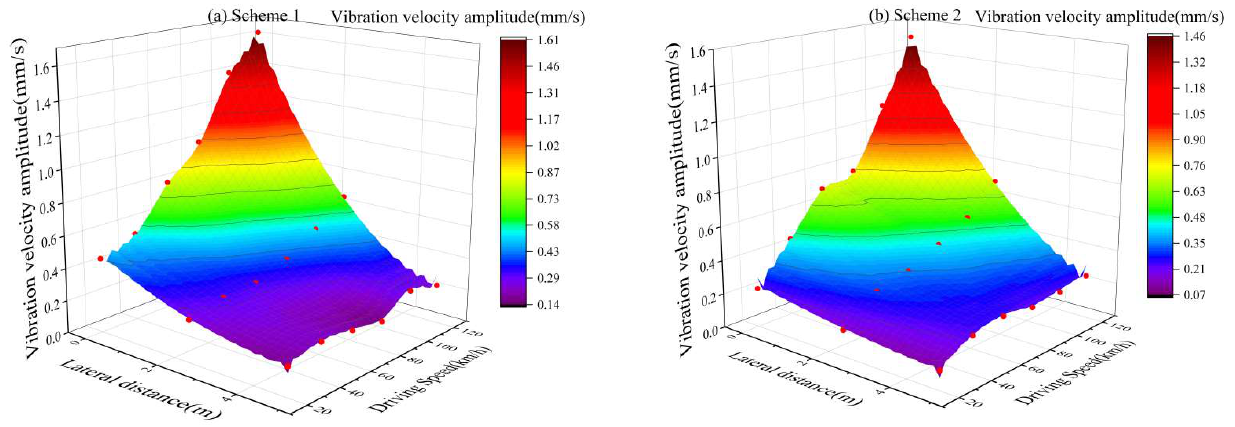
Figure 7. Actual vibration amplitude transverse decay curve.